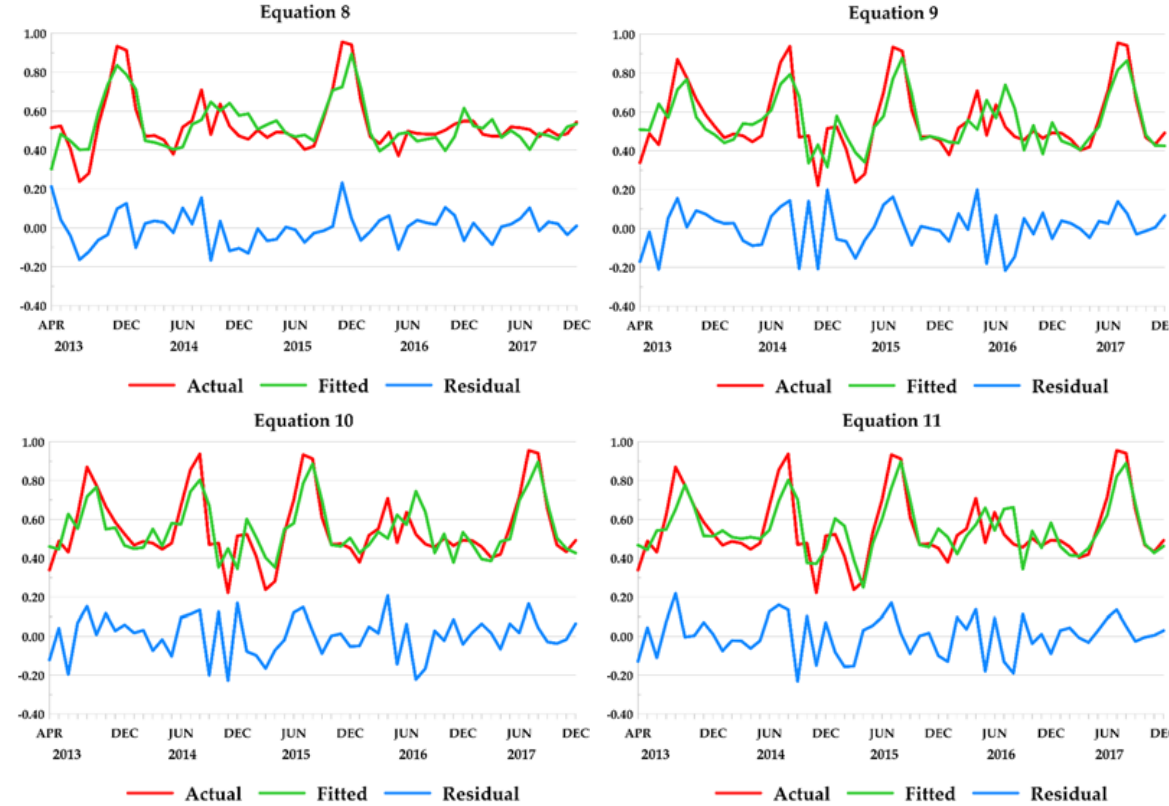
Figure 3. Representation for Maize 1 variety, estimation model and residuals given by Equations (8)–(11).